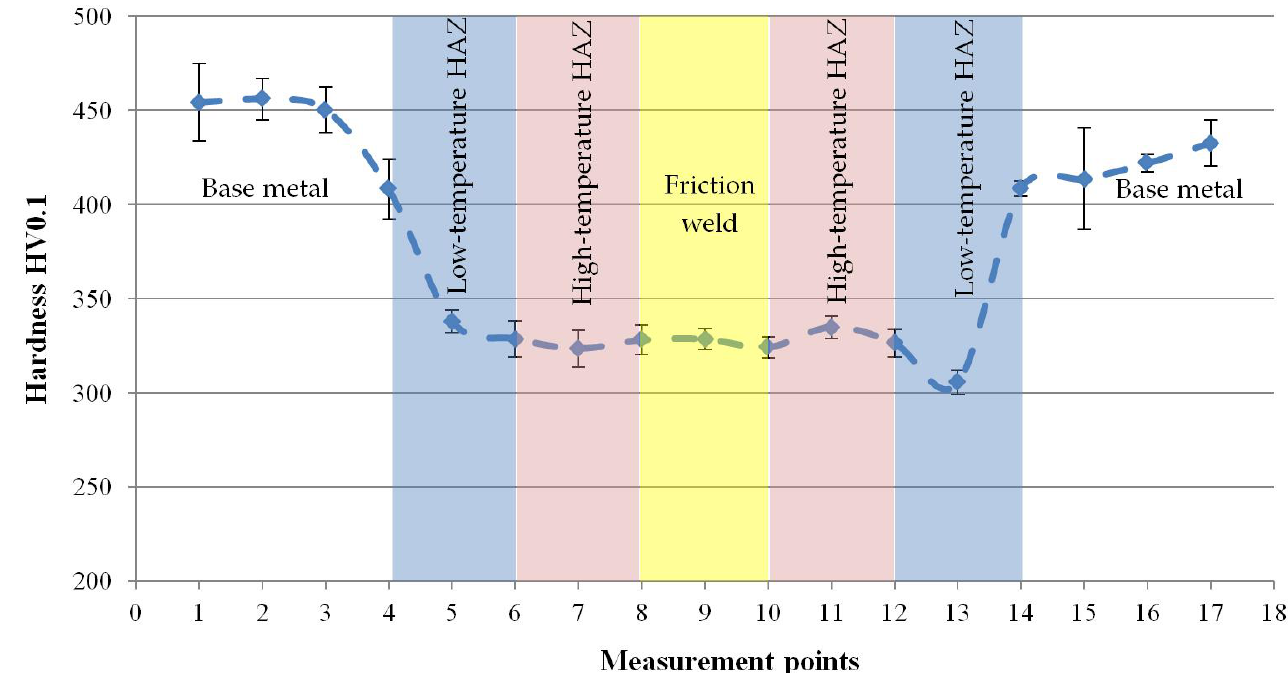
Figure 12. Hardness distribution in the friction-welded joint made of 316L steel after hydrostatic extrusion.